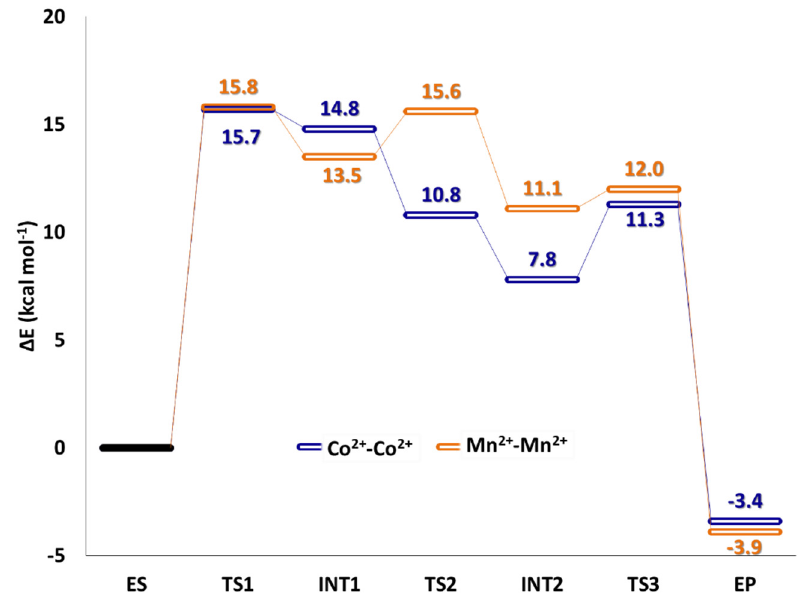
Figure 10. PCM( ε = 4)/B3LYP/6-311+G(d,p)|SDD energetic profiles of hydrolysis mechanism of Co 2+ - Co 2+ and Mn 2+ -Mn 2+ arginase [150,151].